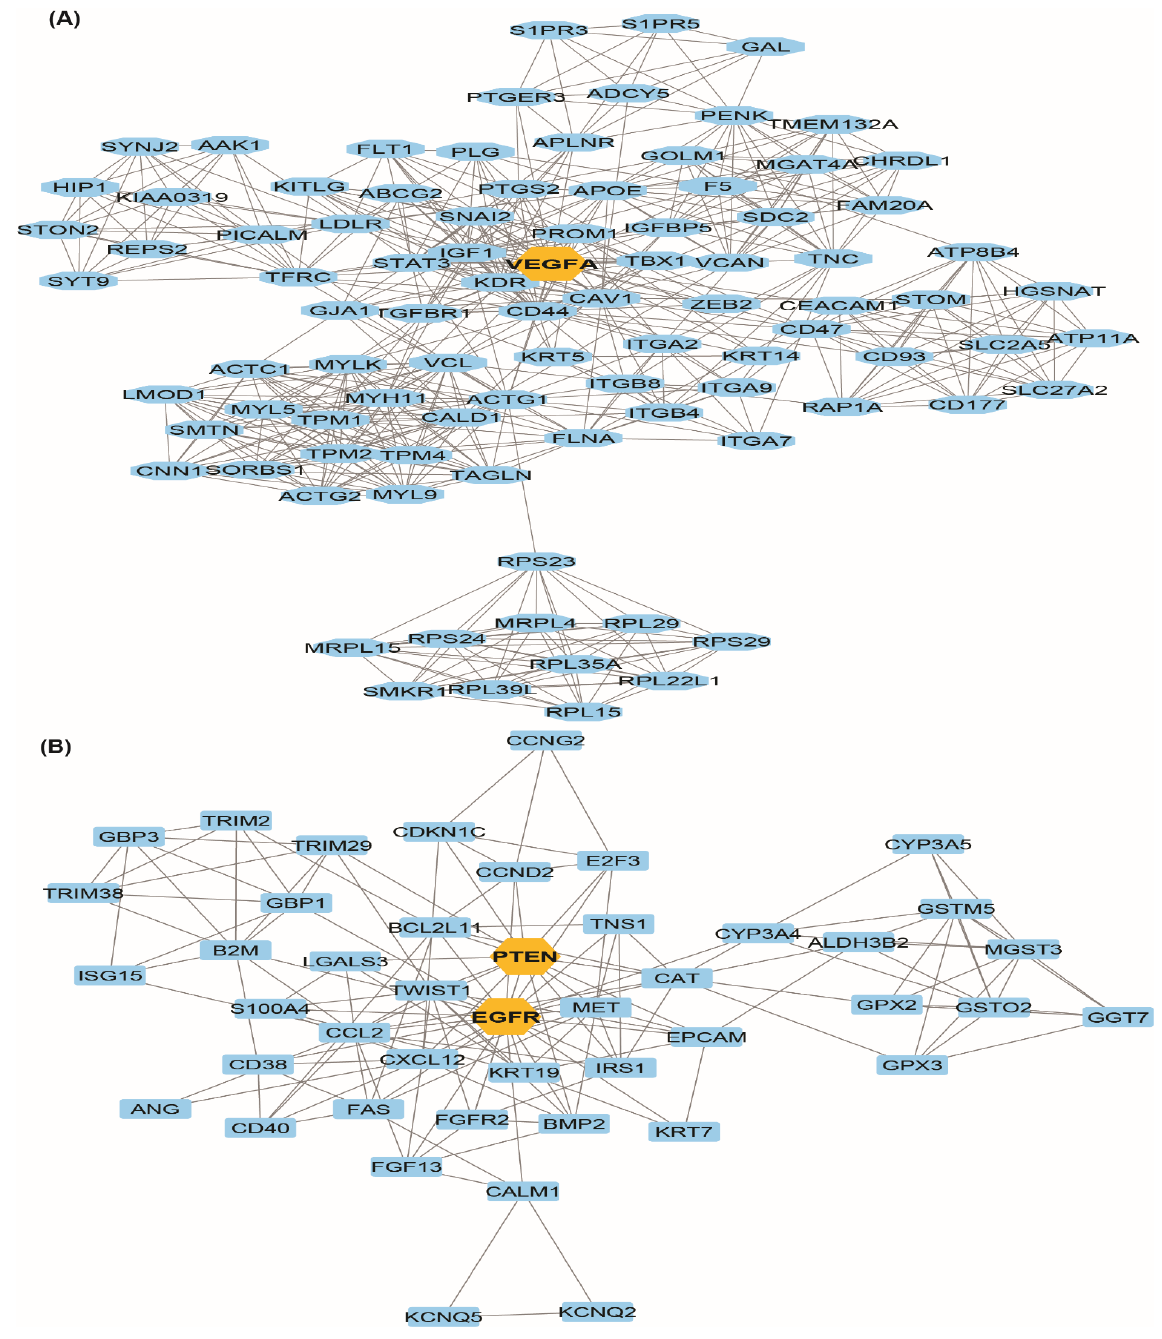
Figure 7. Identification of modules from PPI network. ( A ) Most significant module-A & ( B ) modules-B in the MCODE-PPI network analysis. DEGs is represented by nodes and interaction between them represented by edges.